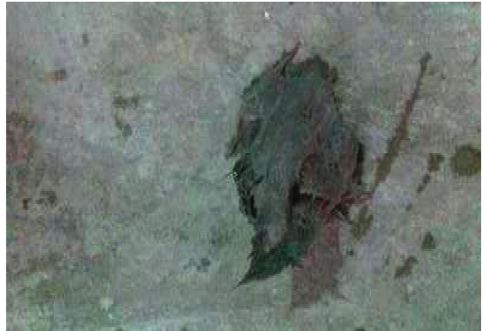
Figure 13: Fiber clusters appearing during stirring.